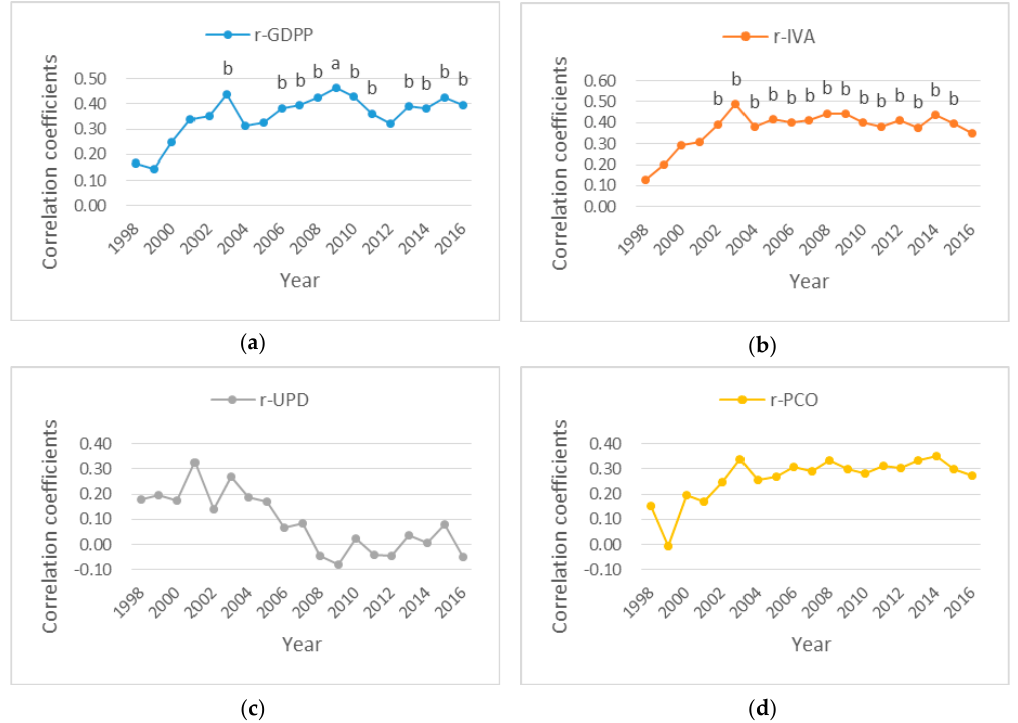
Figure 6. The correlation coefficients between PM 2.5 and socioeconomic factors in Mainland China, 1998–2016. ( a ) Correlation coefficients between PM 2.5 and GDPP. ( b ) Correlation coefficients between PM 2.5 and IVA. ( c ) Correlation coefficients between PM 2.5 and UPD. ( d ) Correlation coefficients between PM 2.5 and PCO. Notes: the letters a and b above the curve point represent coefficients significant at the 1%, 5% levels, respectively. No letters above the curve point indicate